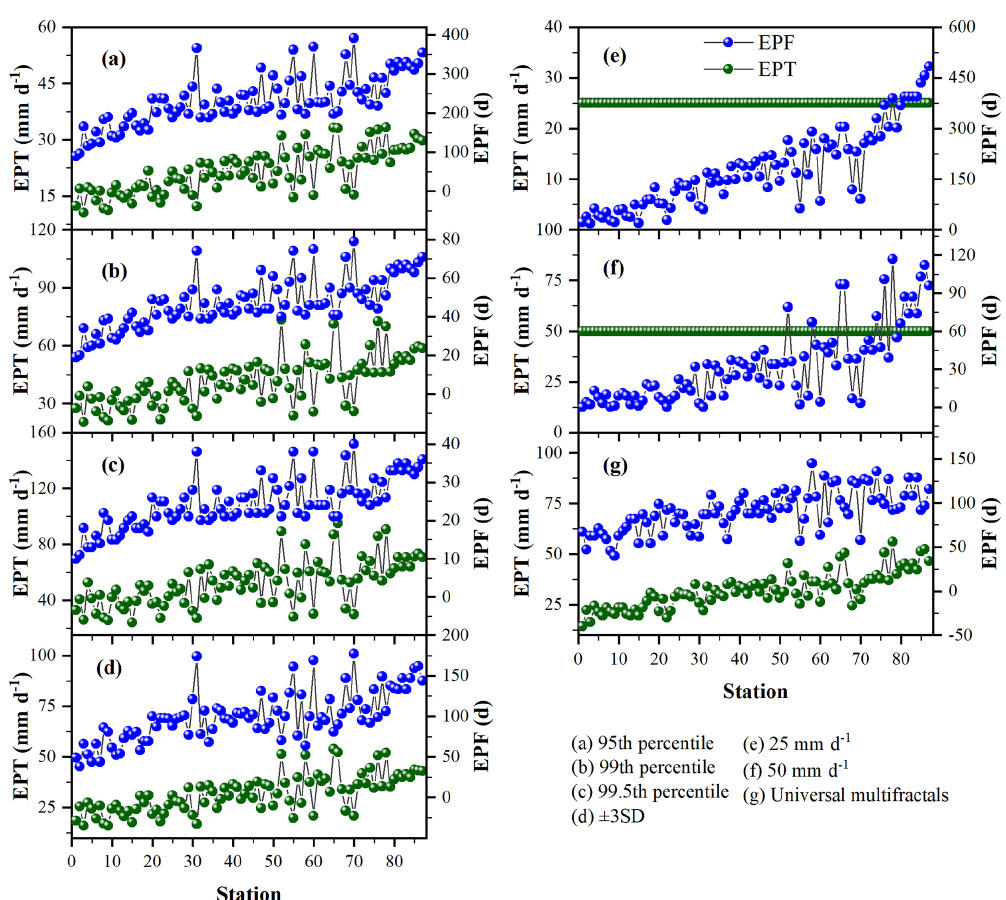
Figure 8. EPTs determined by different methods and the corresponding EP frequencies for 87 stations over the Loess Plateau. The abscissa represents the stations with an increase in the mean annual precipitation from 104 to